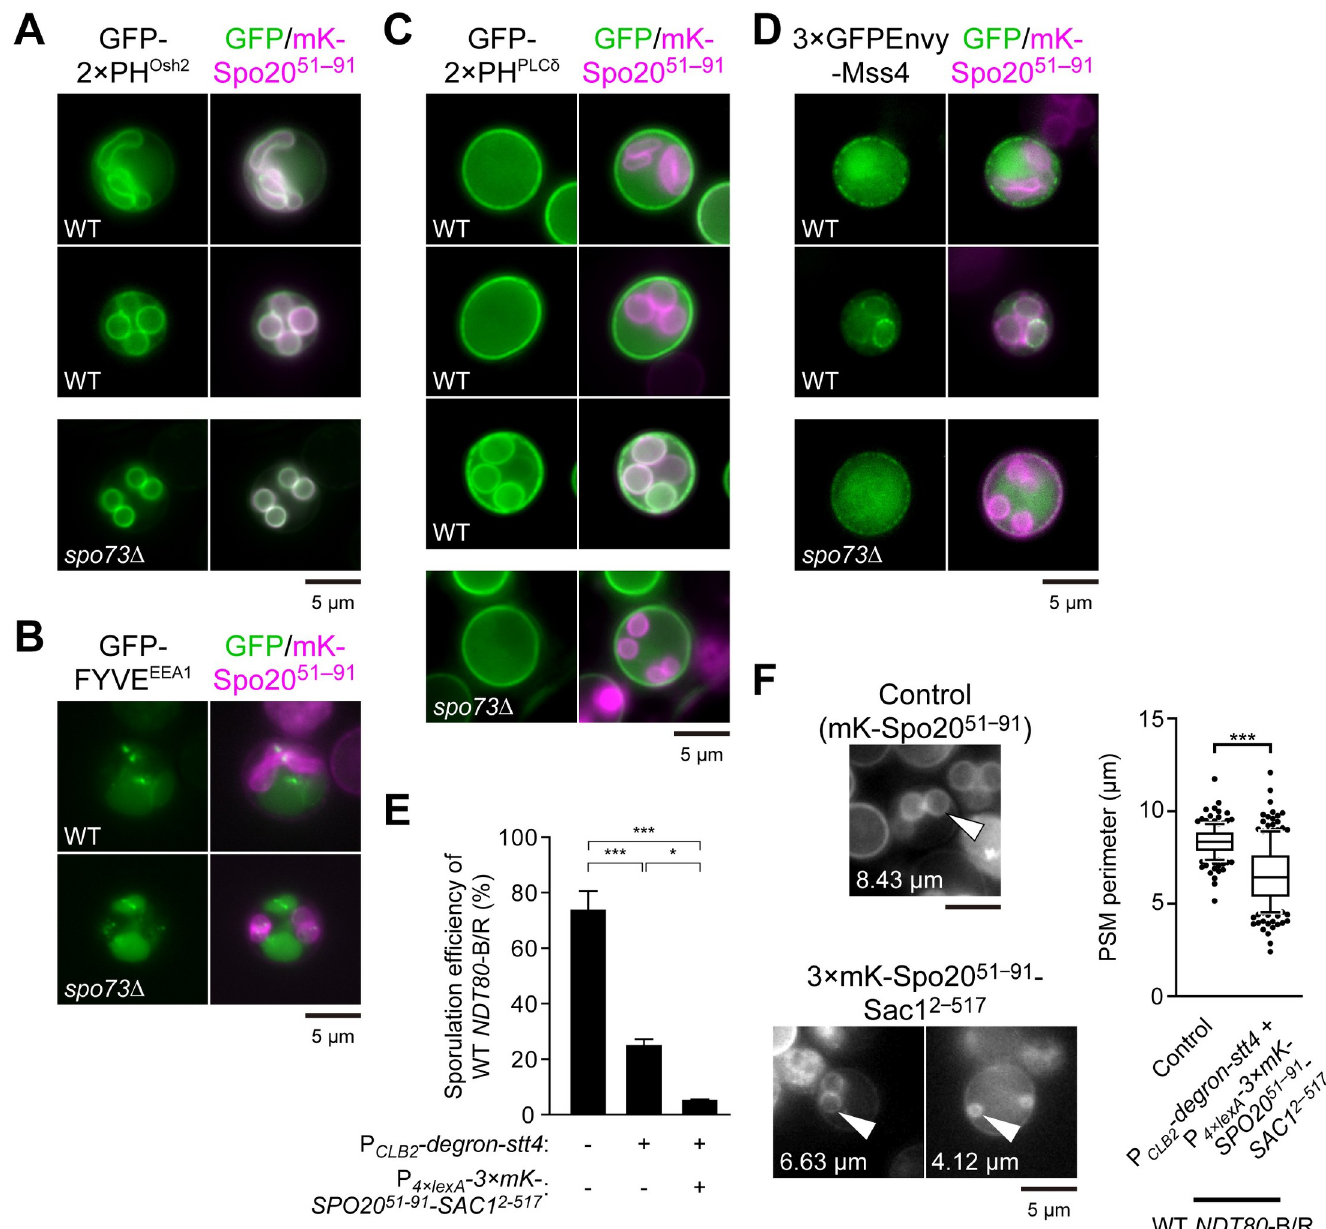
Fig 6. The PSM is distinctly abundant in PI4P. (A) Localization of GFP-2 × PH Osh2 in wild-type (AN120) cells during PSM extension (top) or after PSM closure (bottom), and spo73 Δ (TC545) cells during PSM formation. (B) Localization of GFP-FYVE EEA1 in wild-type (AN120) and spo73 Δ (TC545) cells during PSM formation. (C) Localization of GFP-2 × PH PLC δ in wild-type (AN120) cells during PSM extension (top) or after PSM closure (middle and bottom), and spo73 Δ (TC545) cells during PSM formation. (D) Localization of 3 × GFPEnvy-Mss4 in wild-type (TNY375) cells during PSM extension (top) or after PSM closure (bottom), and spo73 Δ (TNY376) cells during PSM formation. (E) Assessment of sporulation in wild-type NDT80 -B/R P CLB2 -degron-stt4 (TNY473) and producing 3 × mKate2-Spo20 51–91 -Sac1 2–517 from β -estradiol inducible promoter (TNY519). Wild-type NDT80 -B/R (TNY168) was assessed as a control strain. More than 200 cells were observed in three independent colonies of each condition (for a total of > 600 cells). The bar graph shows the mean of the percentage of asci (N = 3). � , p < 0.05, ��� , p < 0.001 (Tukey-Kramer test). (F) Left: Representative cells are shown. The perimeter of the PSM indicated by white arrow heads are shown. Right: Assessment of perimeter of the PSM in wild-type NDT80 -B/R producing mKate2-Spo20 51–91 (TNY197), as a control, or wild-type NDT80 -B/R P CLB2 -degron-stt4 producing 3 × mKate2-Spo20 51–91 -Sac1 2–517 from β -estradiol inducible promoter (TNY519). More than 50 PSMs were measured in three independent colonies of each strain (for a total of 173 or 204 PSMs, respectively). The whiskers indicate the 10th and 90th percentiles and dots indicate outliers. ��� , p < 0.001 (Student’s t test). mK, mKate2. mKate2-Spo20 51–91 , a PSM marker. Scale bar, 5 μ m.